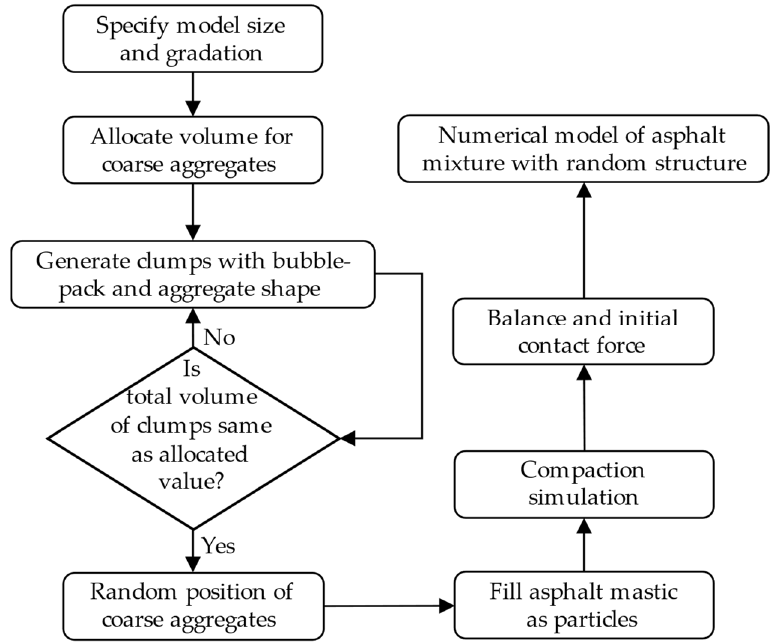
Figure 13. Flowchart of DEM modeling of asphalt mixtures.